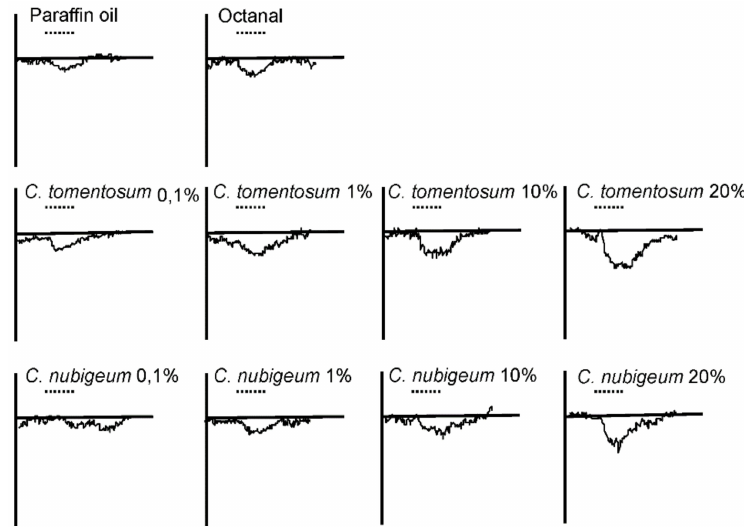
Figure 9. Examples of electroantennography (EAG) response waveforms of Sitophilus zeamais to 10 µ L of the di ff erent compounds at di ff erent concentrations, compared with the response to the controls (para ffi n oil). Dotted line corresponds to 1 s stimulus.